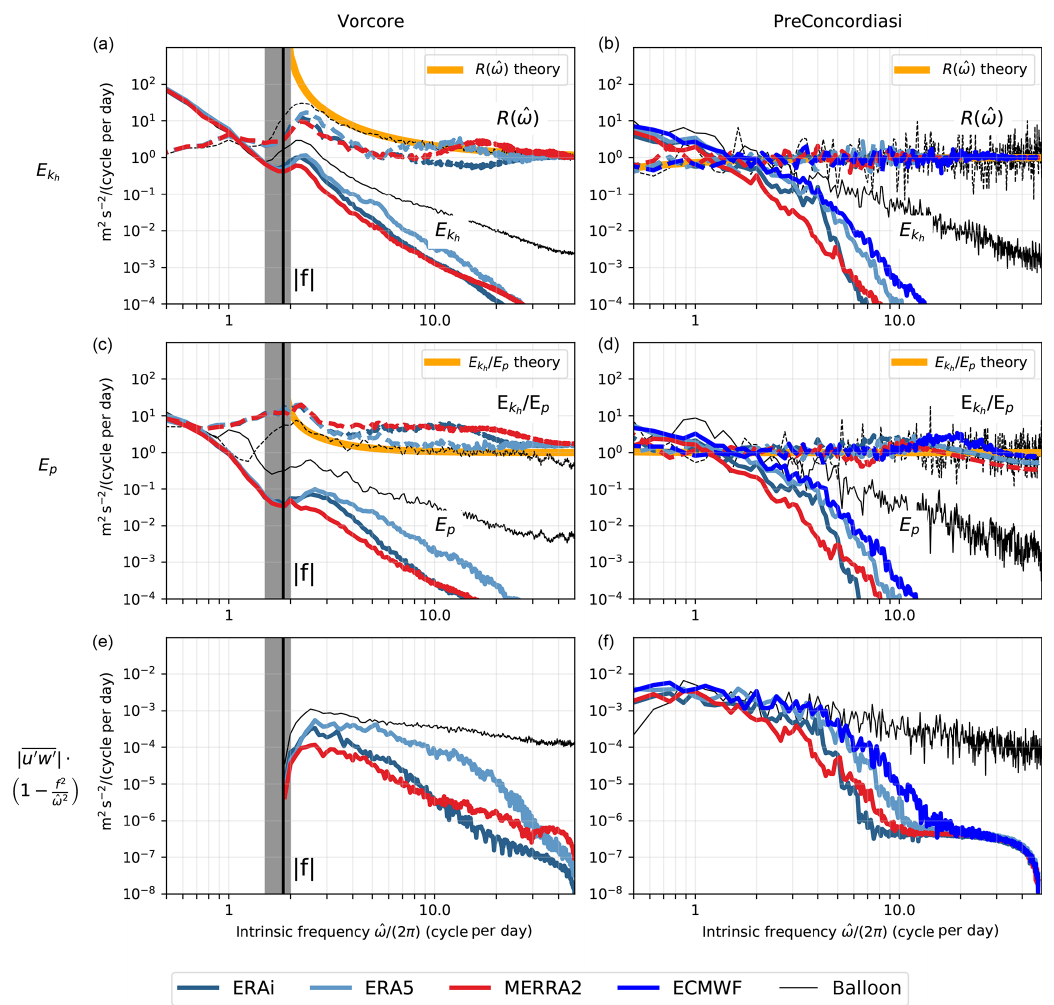
Figure 3. Intrinsic frequency spectra of (a, b) horizontal kinetic energy per unit mass E k (solid) and rotary ratio R( ˆ ω) (dashed), (c, d) po- h /E p , and (e, f) modules of the zonal pseudo-momentum flux per tential energy per unit mass E p and ratio of kinetic over potential energy E k h (cid:16) (cid:17) | u (cid:48) w (cid:48) | during the polar Vorcore (a, c, e) campaign and the equatorial PreConcordiasi (b, d, f) campaign. The black unit mass 1 − f 2 / ˆ ω 2 curve on each plot corresponds to balloon observations, while the spectra estimated from isopycnic trajectories in different (re)analyses are in color. The vertical black line indicates the mean Coriolis parameter | f | , while the shaded gray area depicts its variability along the balloon trajectories. The trajectories used to compute the spectra are 8d trajectories starting at the balloon